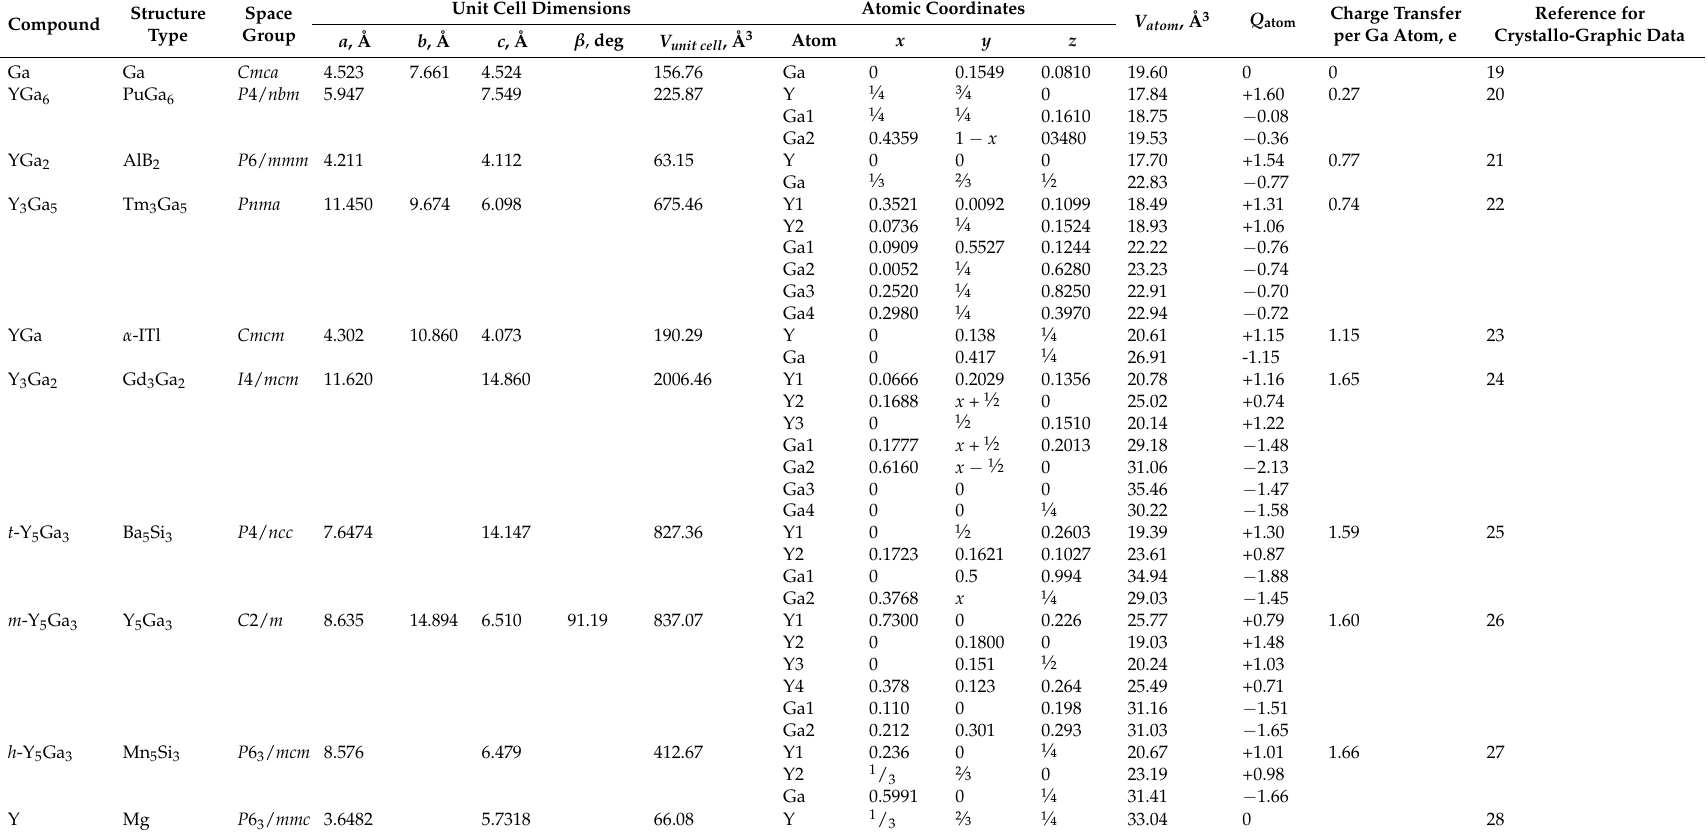
Table 1. Crystallographic and quantum chemical information for the yttrium gallides.